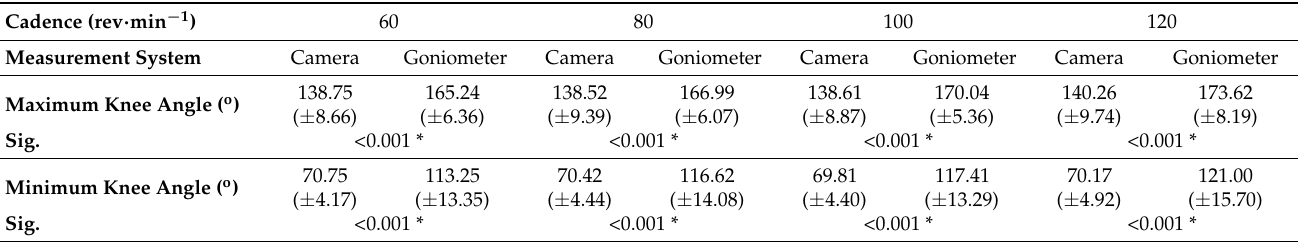
Table 3. Comparison of mean maximum and mean minimum knee angle recorded across 10 pedal revolutions.